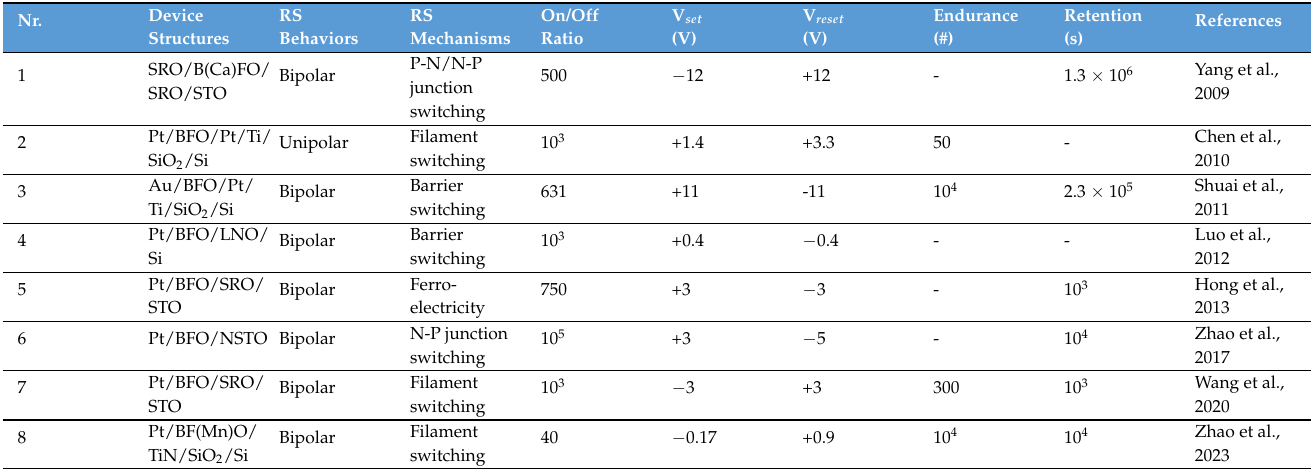
Table 2. RS properties of several BFO-based memristive devices, including device structures, RS behaviors, RS mechanisms with their respective types, on/off ratio, set voltages (V set ), reset voltages (V reset ), endurance, and retention in Ref.